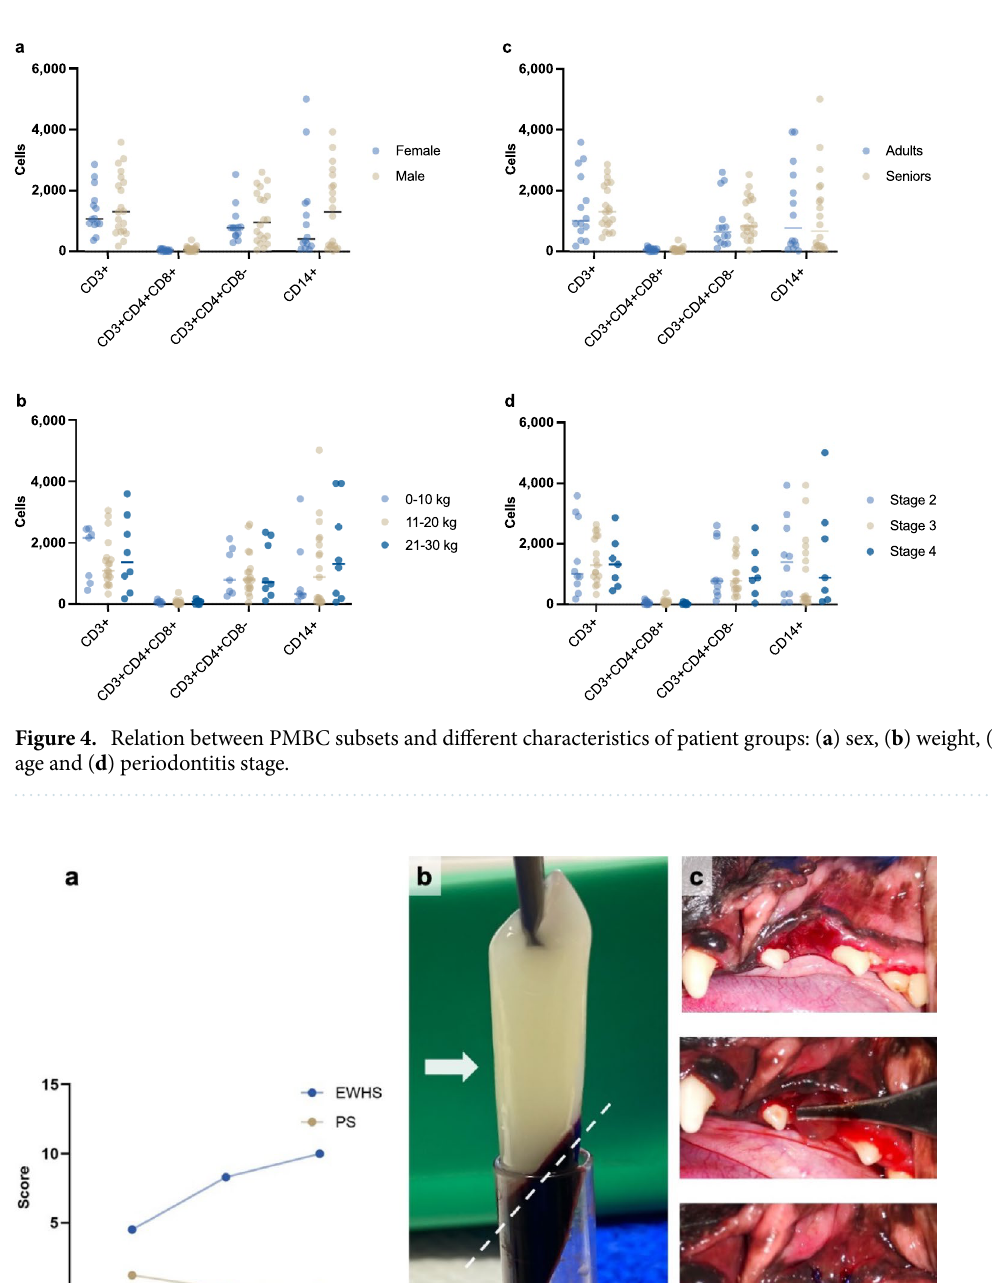
PRF 27 . The chronic inflammatory process of periodontal disease with constant immunological stimulation and